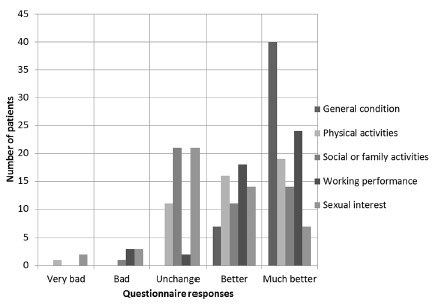
Graph with the result of BAROS by area searched